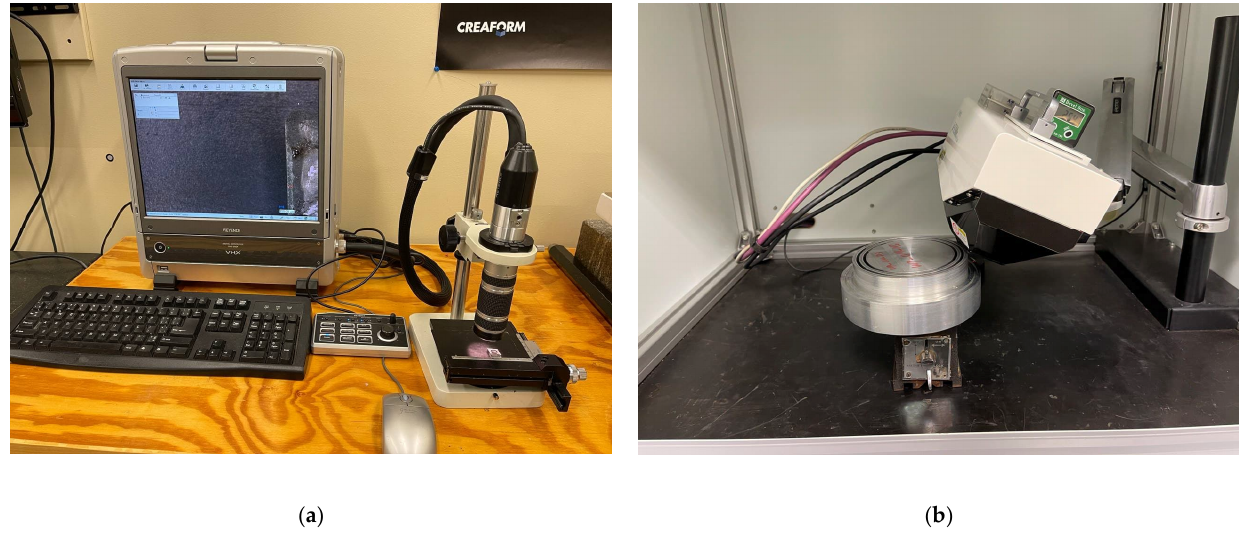
Figure 3. ( a ) Digital Microscope VHX-500F for measuring tool wear and ( b ) a Pulstec µ-X360n XRD machine for measuring residual stresses.